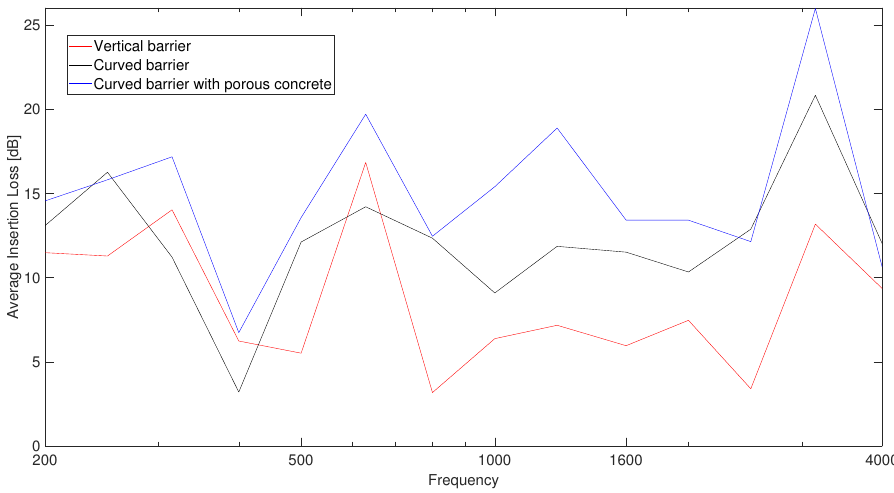
Figure 18. Insertion loss calculated for the three proposed noise